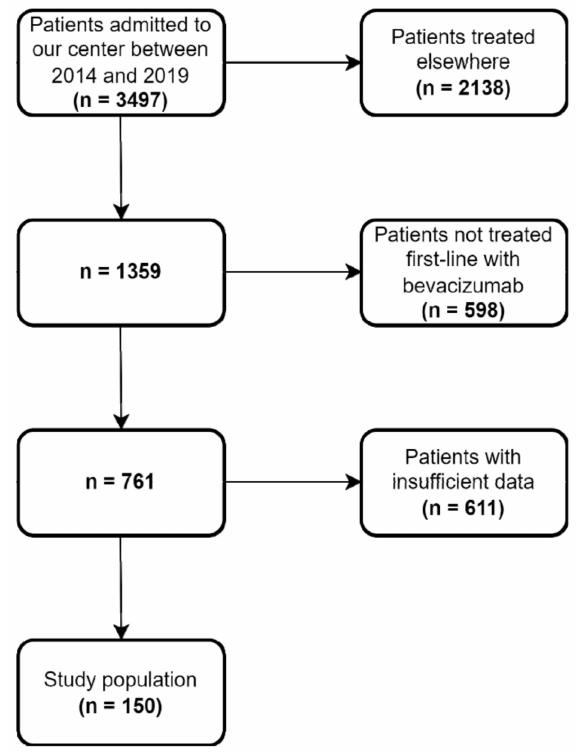
Figure 1. Flowchart detailing patient selection for the study.